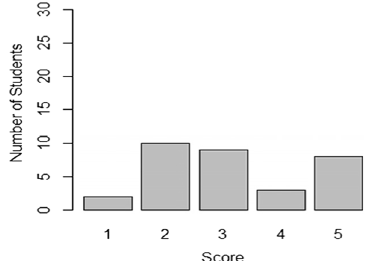
Fig. 11 Distribution of the scores in Screen